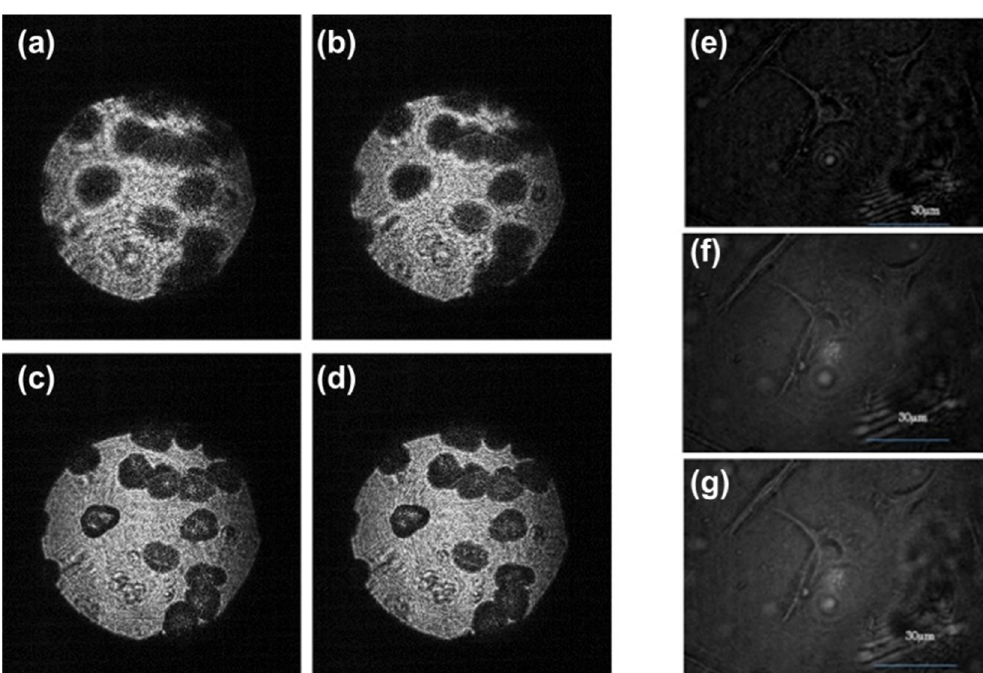
Figure 22. Recorded images with a ( a ) 2 step phase fringe = 0, π /2 (left-top); ( b ) 4 step phase fringe = 0, π /2, π /4, 7 π /4 (right-top); ( c ) 6 step phase fringe = π /4, 7 π /4, 3 π /8, 13 π /8, π /8, 15 π /8, 0, π /2 (left-bottom); and ( d ) 8 step fringe with phase = 3 π /8, 13 π /8, π /8, 15 π /8, 0, π /2, π /4, 7 π /4 (right-bottom). Reconstructed images of the living cell B16F10 with a ( e ) 2 step phase fringe (top), ( f ) 6 step phase fringe (middle) and ( g ) 8 step phase fringe (bottom).